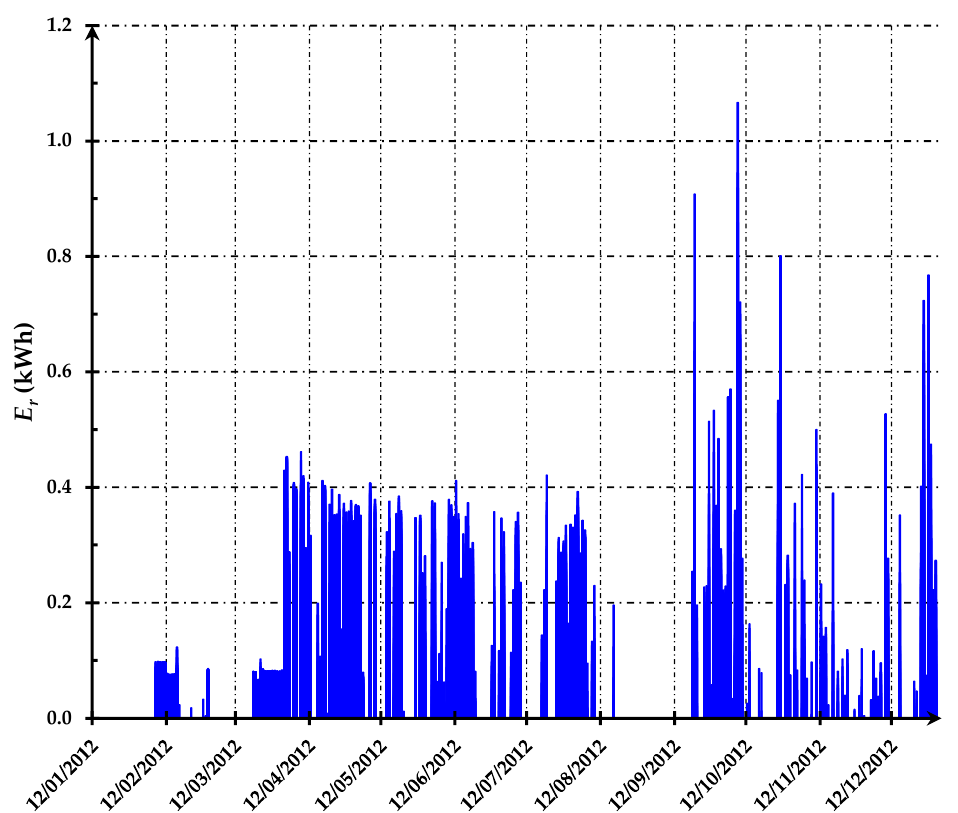
Figure 13. Active energy (Er) returned to the grid (rural power system) in 2012.